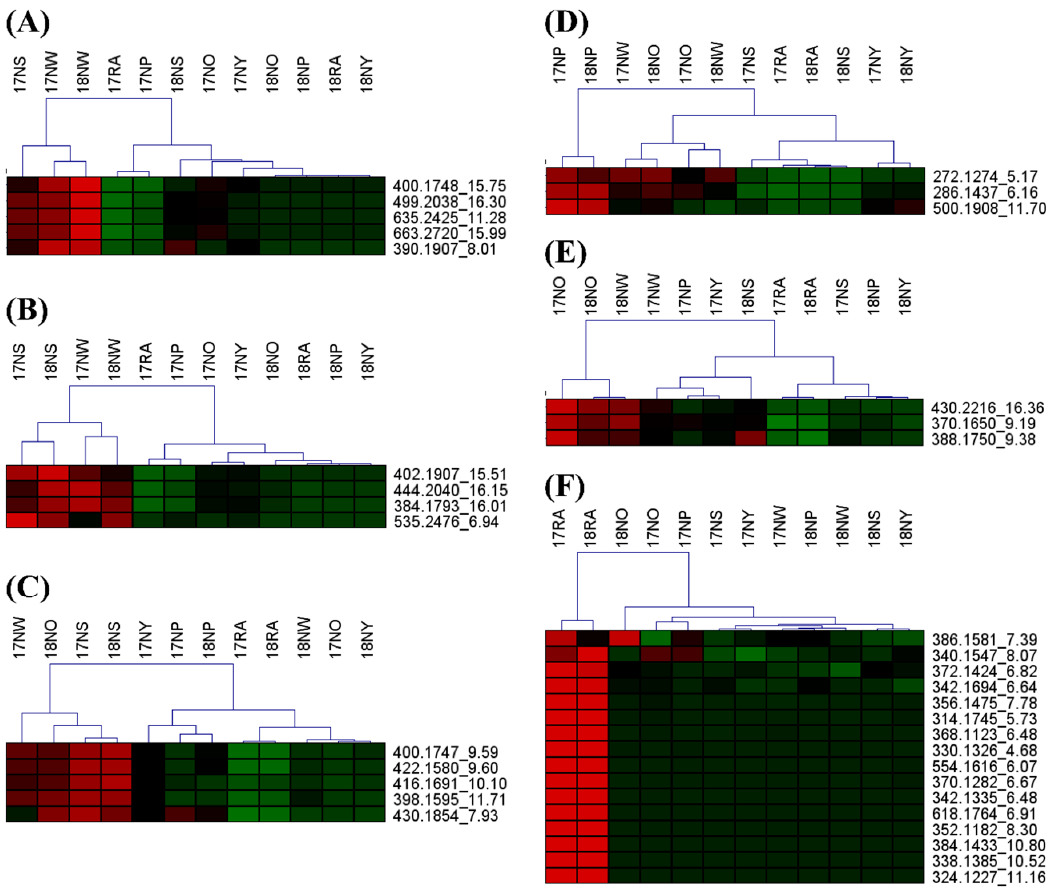
Figure 4. Heatmaps of the molecular features illustrating K-means clustering for the 58 alkaloids of P. nudicaule and P. rhoeas derived from molecular network-guided analysis. Specimens from each analysis were hierarchically clustered. Representative metabolites were proposed for ( a ) NW, ( b ) NS and NW, ( c ) NS, ( d ) NP, ( e ) NO, and ( f ) RA.